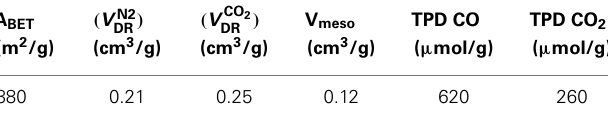
Table 1 | Surface characteristics of GAC